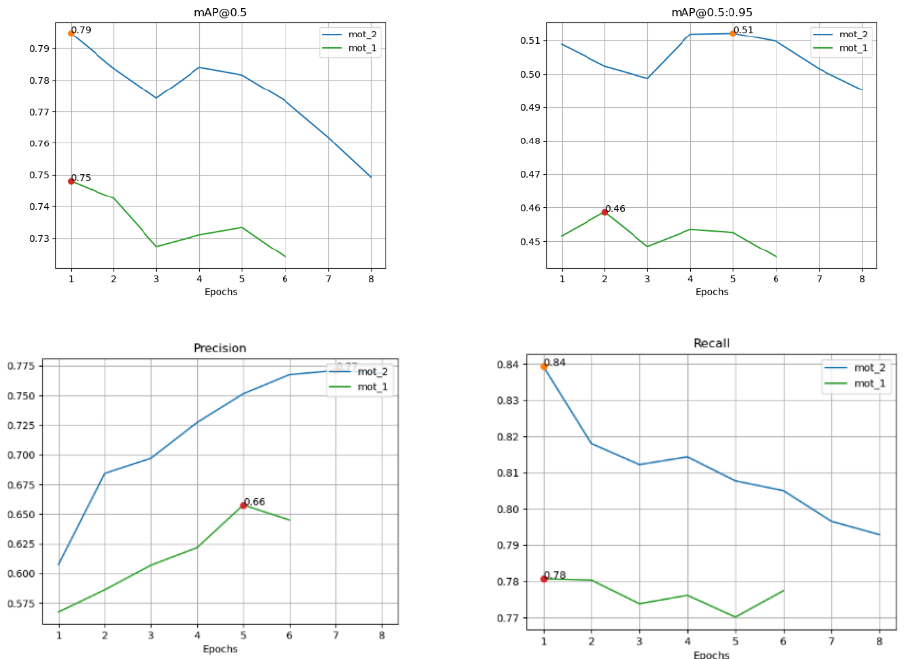
Figure 14. Performance metrics for the MOT17Det dataset.